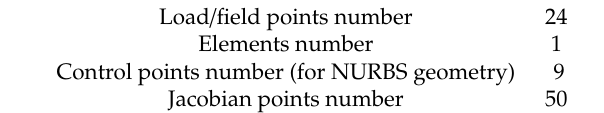
Table 3. Data to analyze the plane strain problem with the proposed method.